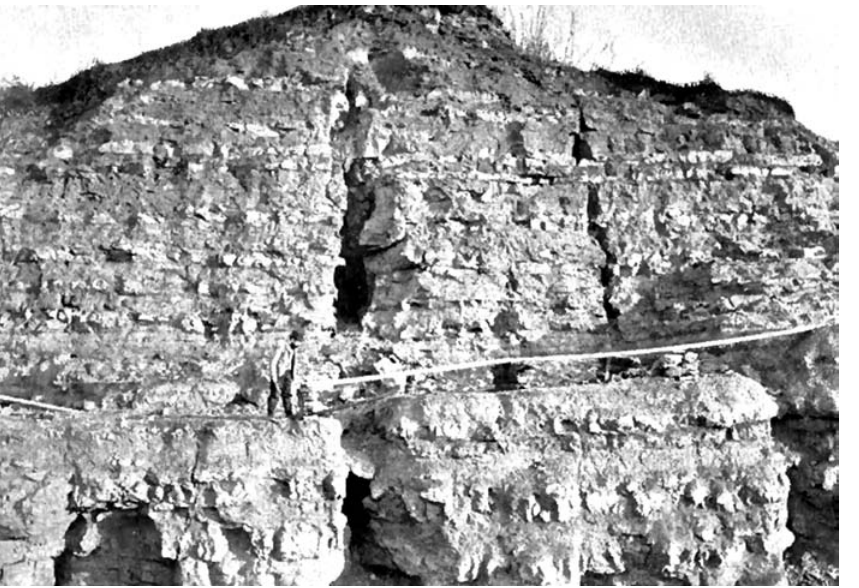
Figure 7 Fissures containing Pleistocene fauna from Ightham in Kent. Note figure on ledge for